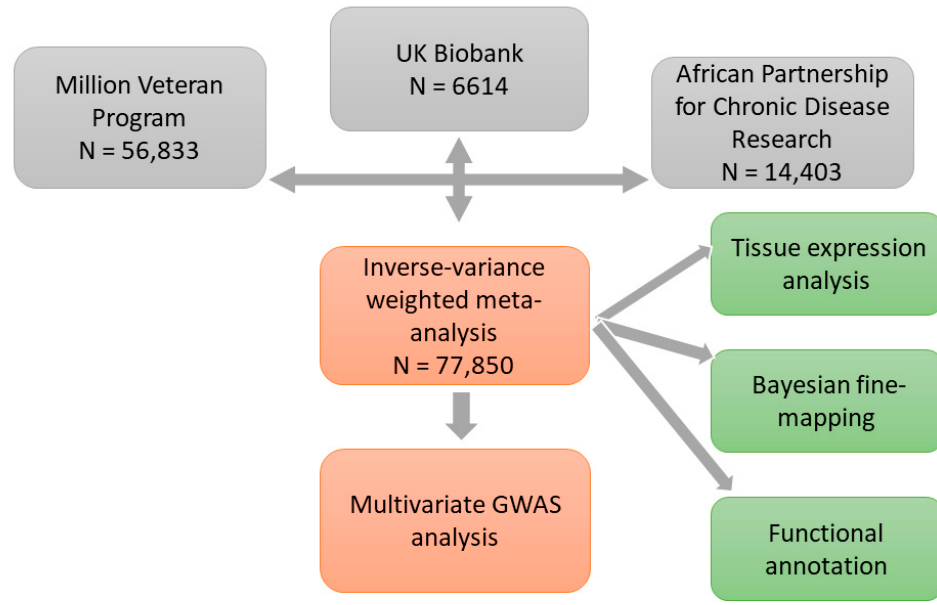
Figure 1. Study design schematic for discovery and validation of loci. APCDR; African Partnership for Control of Disease Research, UKB; United Kingdom Biobank, MVP; Million Veteran Program.